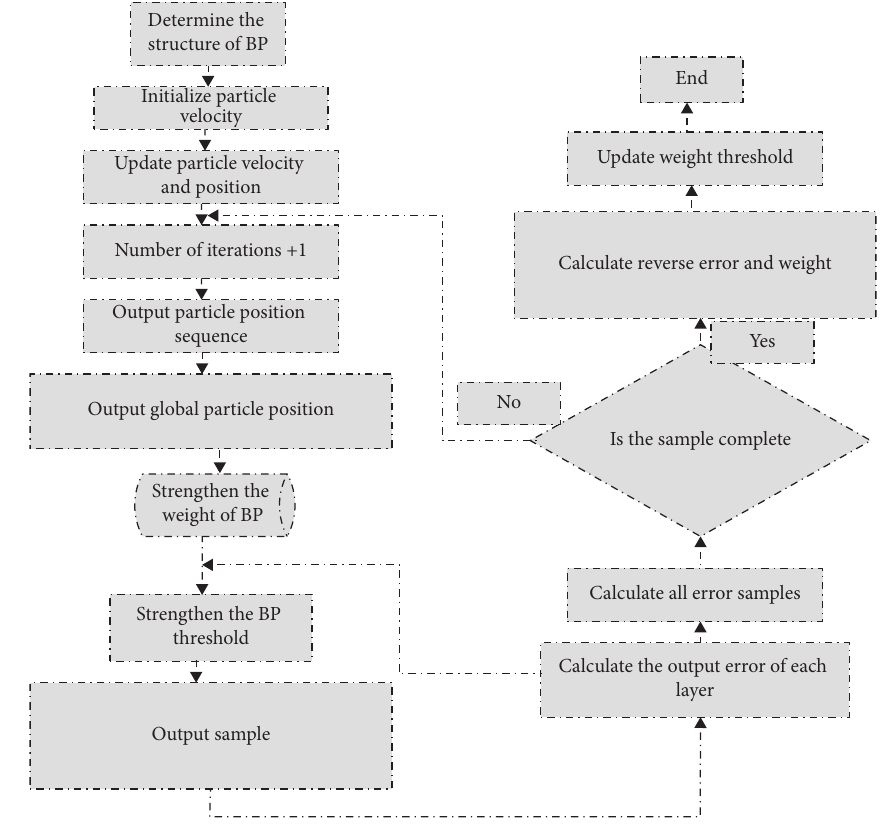
Figure 3: Flowchart of PSO-BP online teaching quality evaluation.